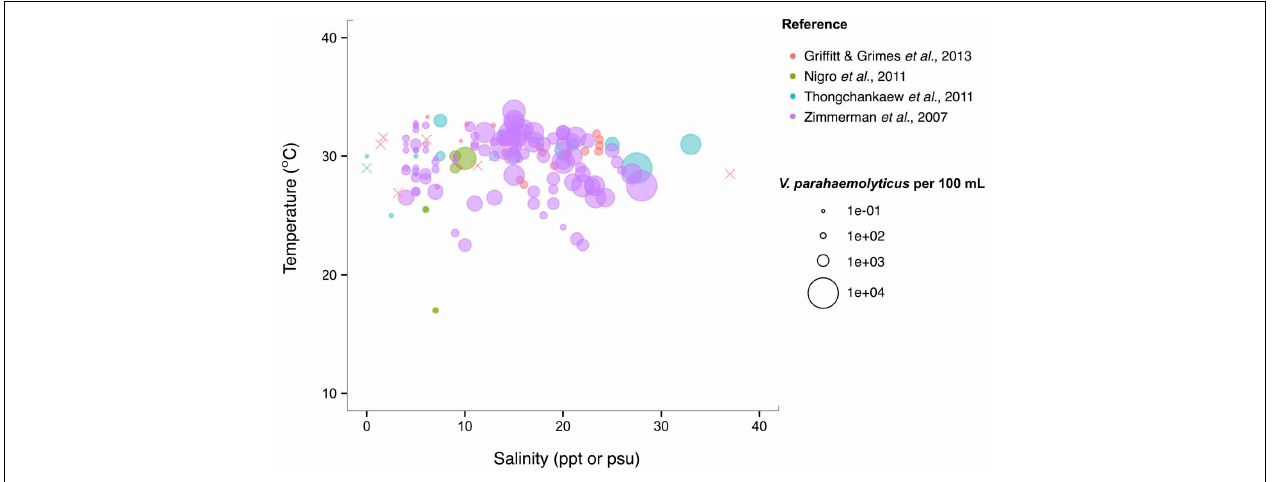
FIGURE 6 | V. parahaemolyticus favors high temperatures but is relatively unconstrained by salinity. Concentrations, i.e., MPN-estimated CFU or molecular marker gene copies per 100mL, reported in different studies are plotted against the temperature ( ◦ C) and salinity values (ppt